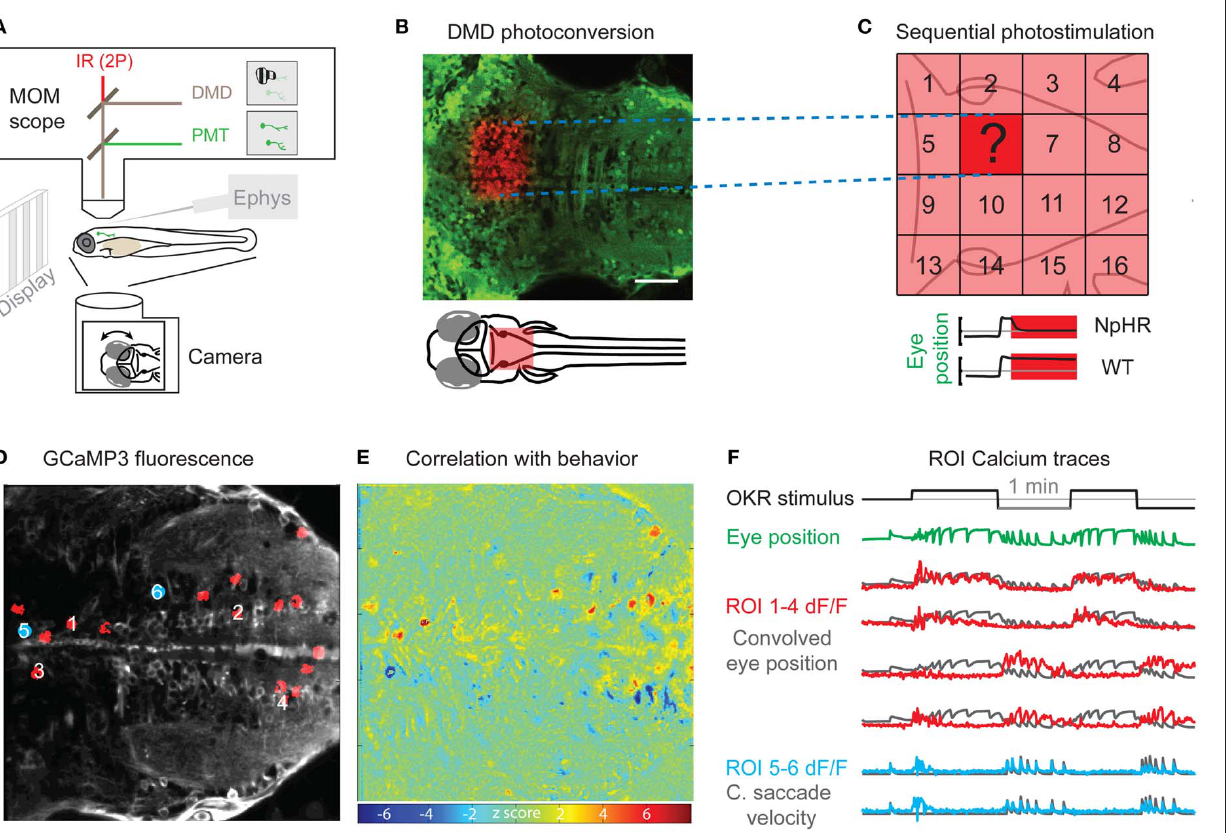
FIGURE 1 | Perturbation and Measurement of brain activity via optogenetics. (A) Scheme of a moveable objective microscope (MOM) that allows two photon (2P) calcium imaging (PMT, photomultiplier tubes) and photostimulation via a digital micro mirror device (DMD). At the same time, the animal can be visually stimulated and eye or tail movements are recorded with a camera. (B) A rectangular region of interest was photoconverted with the DMD device in an Et(E1b:Gal4)s1101t; Tg(UAS:Kaede)s1999t transgenic animal. (C) Schematic for the systematic mapping of circuit function by measuring behavioral performance (e.g., eye position stability) during sequential photostimulation (16 regions shown here) in animals transgenic for optogenetic actuators (e.g., halorhodopsin, NpHR). The question mark illustrates an individual tested region as shown in (B) . (D) Averaged frame of a calcium imaging time series during visual optokinetic response (OKR) stimulation in an Et(E1b:Gal4)s1101t; Tg(UAS:GCaMP3) transgenic 5-day-old animal. Red regions of interest (ROIs) correspond to highly correlated pixels in